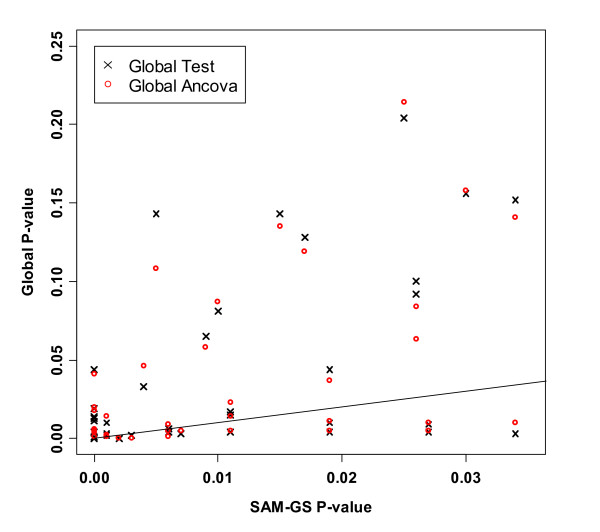
Lowest P-values in the p53 data analysis: p-values of Global Test and ANCOVA Global Test after the VSN normalization vs. SAM-GS p-values after the VSN normalization. The line indicates equal p-values between SAM-GS and Global Tests.